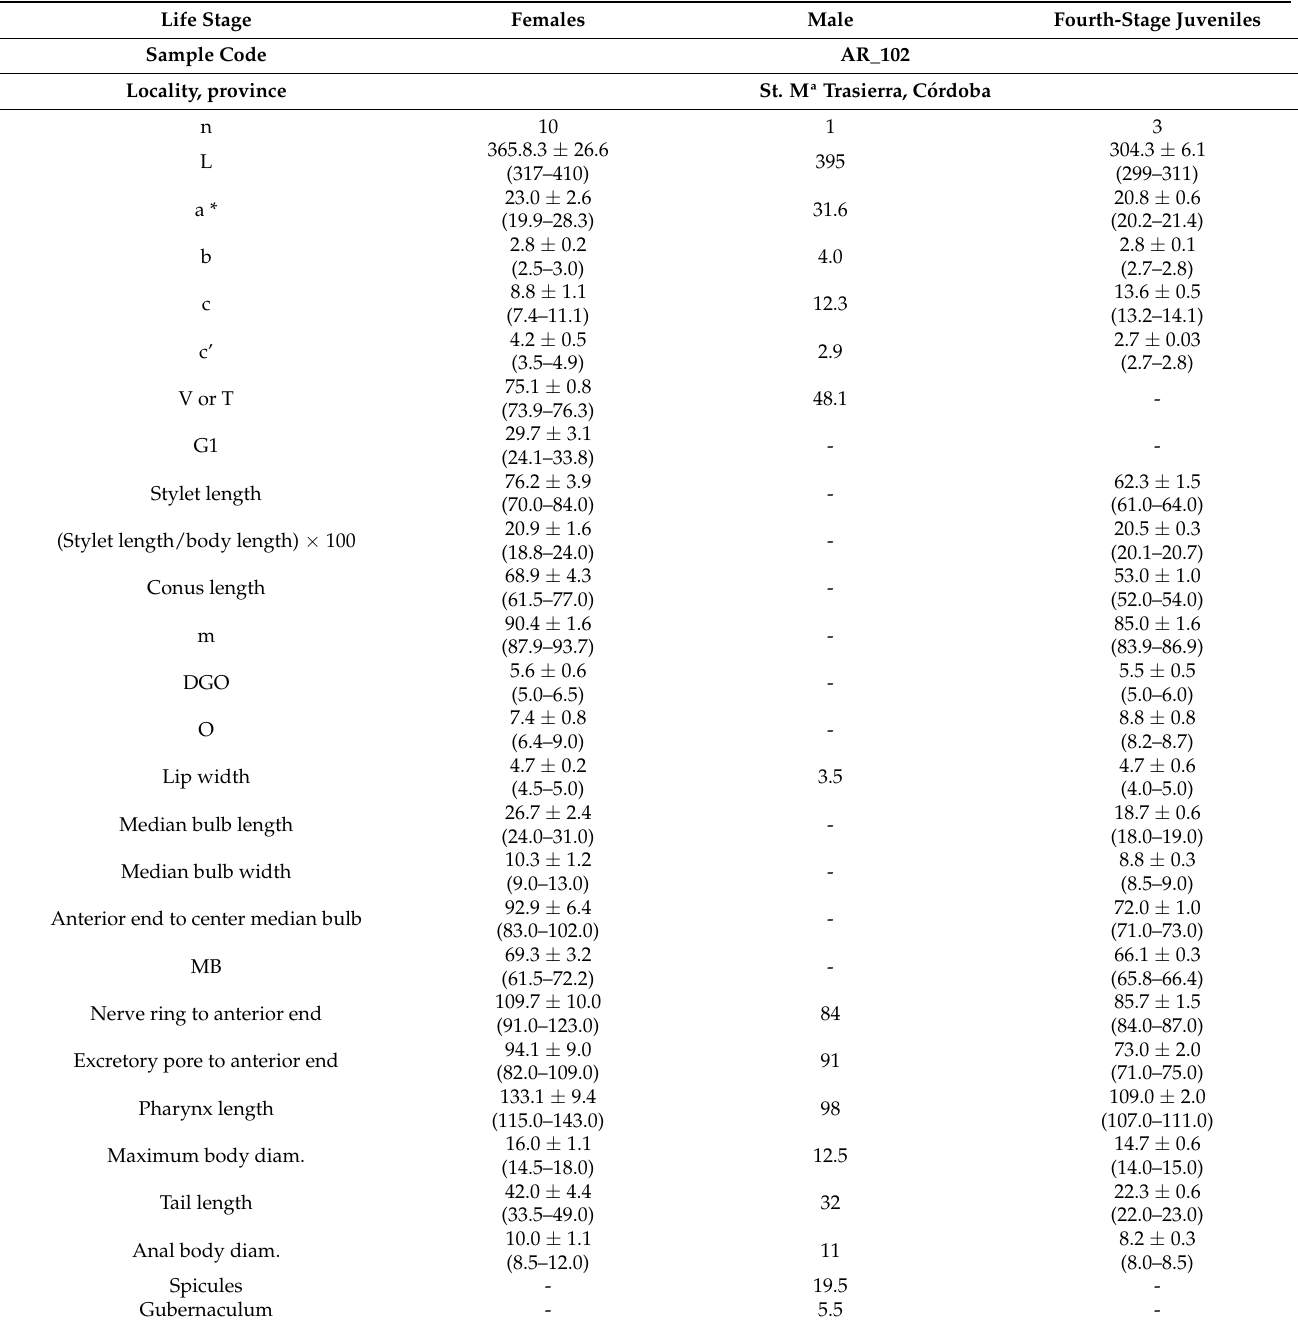
Table 7. Morphometrics of Paratylenchus macrodorus Brzeski, 1963 from Santa Mar í a de Trasierra, C ó rdoba, Spain. All measurements are in µ m and in the form: mean ± s.d.